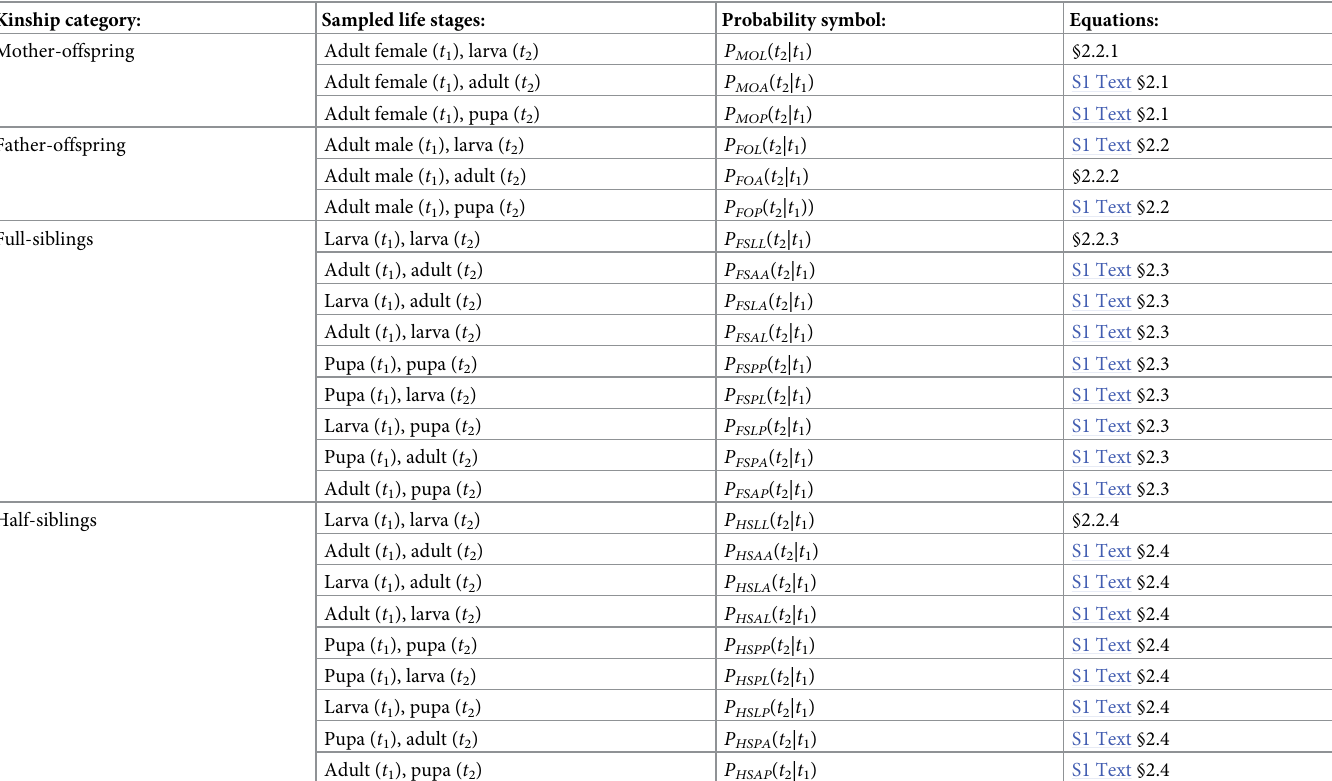
Table 2. Kinship categories, sampled life stages, sampling times, and probability symbols used in close-kin mark-recapture analysis. Kinship category: Sampled life